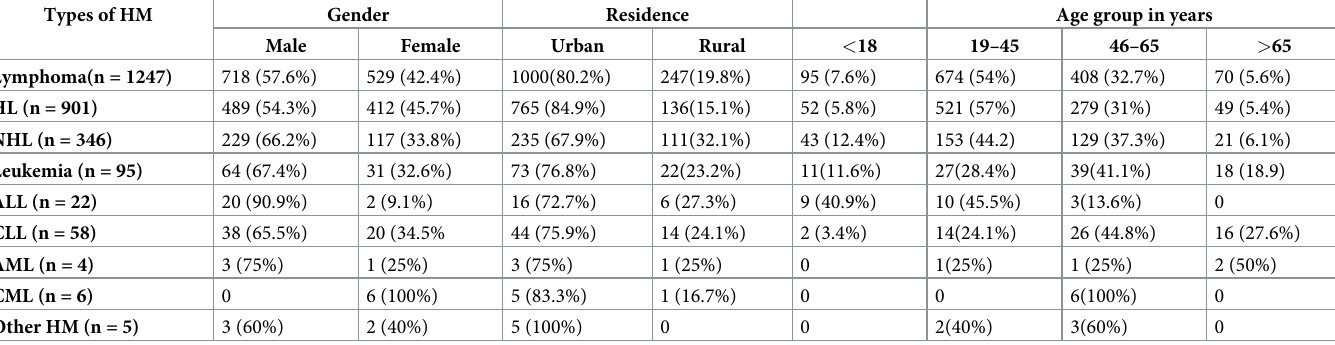
Table 2. Classification of hematological abnormality of study participants at UoG-CSH and Bahir-Dar Felegehiwot comprehensive specialized Hospital: Northwest Ethiopia. Types of HM